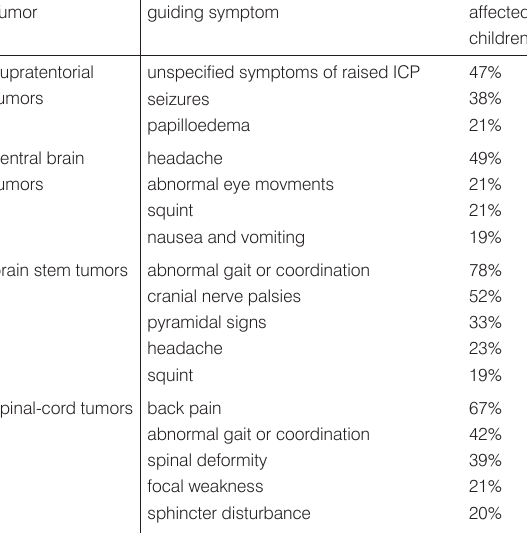
Table 4. Clinical presentation of childhood CNS tumors [ 10 ] Tumor guiding